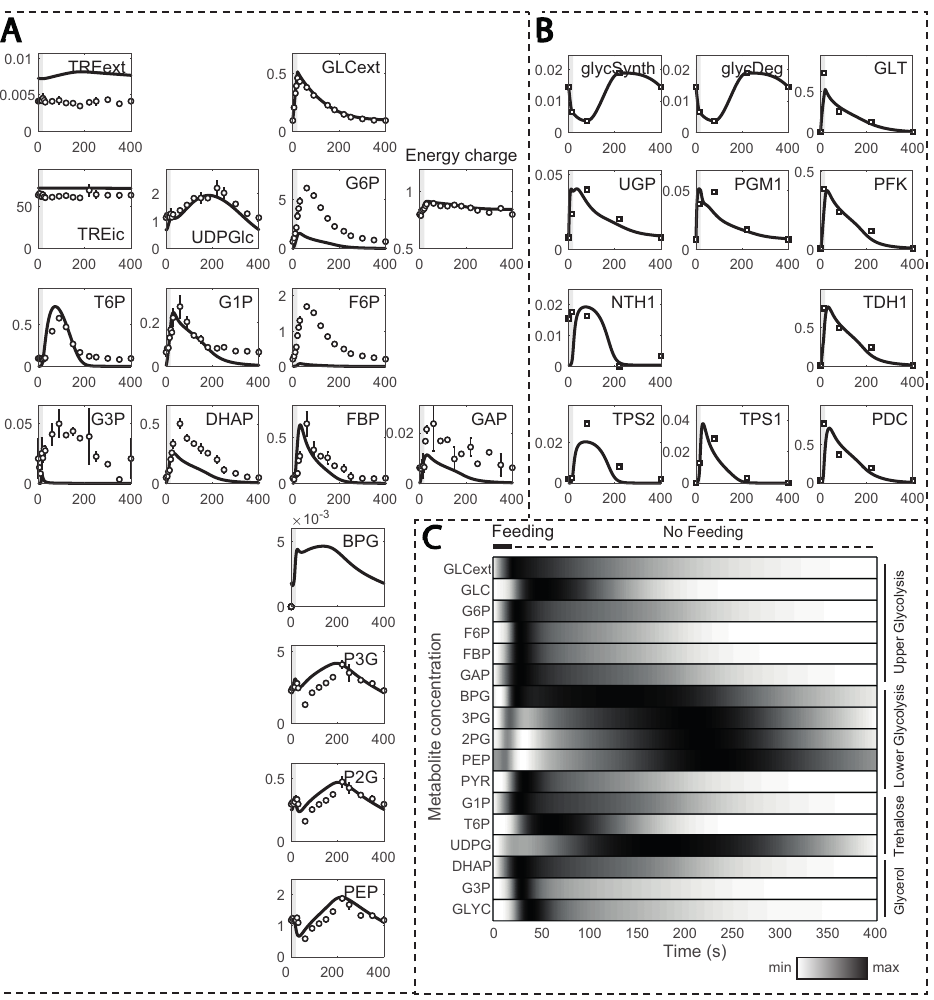
Figure 4. Model simulations in comparison to experimental observations: ( A ) metabolite concentra- tions; and ( B ) reaction rates estimated from 13C enrichment data over one cycle (400 s). Metabolite concentrations and reaction rates are displayed in the y-axis (in mM and mM s − 1 , respectively) and time in the x-axis; ( C ) normalized metabolite concentrations during one feeding cycle. Darker colours indicate values closer to the maximum, while brighter ones indicate values closer to the